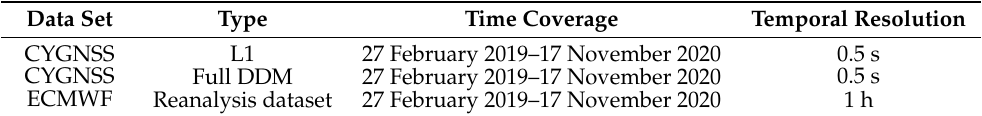
Table 1. Data set